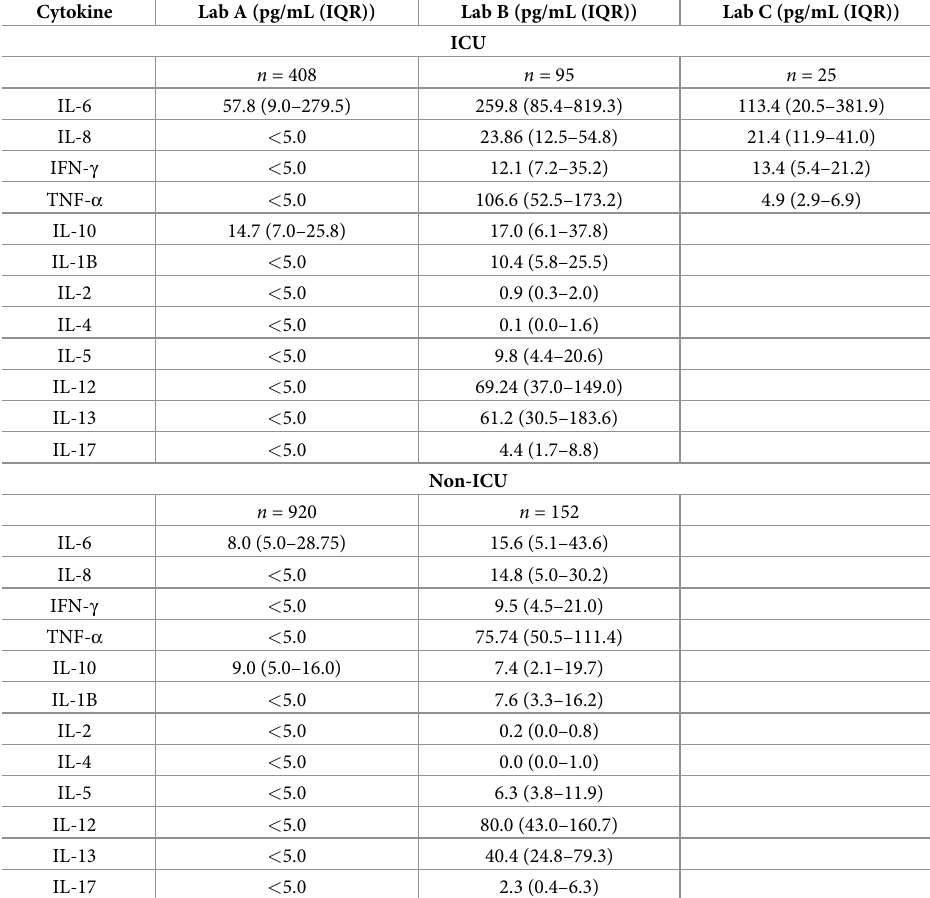
Table 1. Median values of cytokine concentrations among hospitalized patients with COVID-19 by severity of illness. Cytokine Lab A (pg/mL (IQR)) Lab B (pg/mL